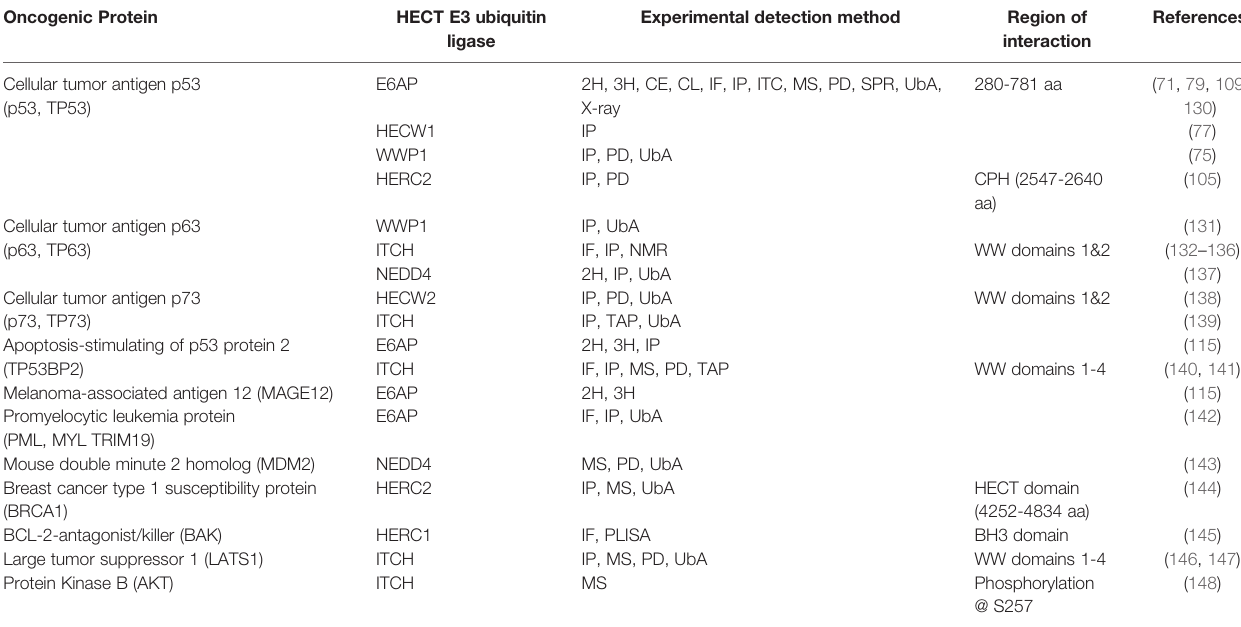
TABLE 1 | Examples of experimentally observed protein-protein interaction of oncogenic proteins with HECT E3 ubiquitin ligases. Oncogenic